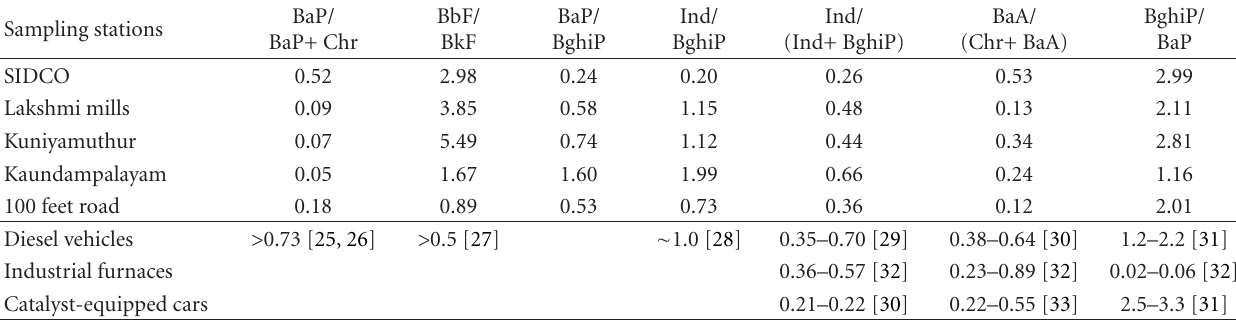
Table 5: Site-specific diagnostic ratio of PAHs and their probable